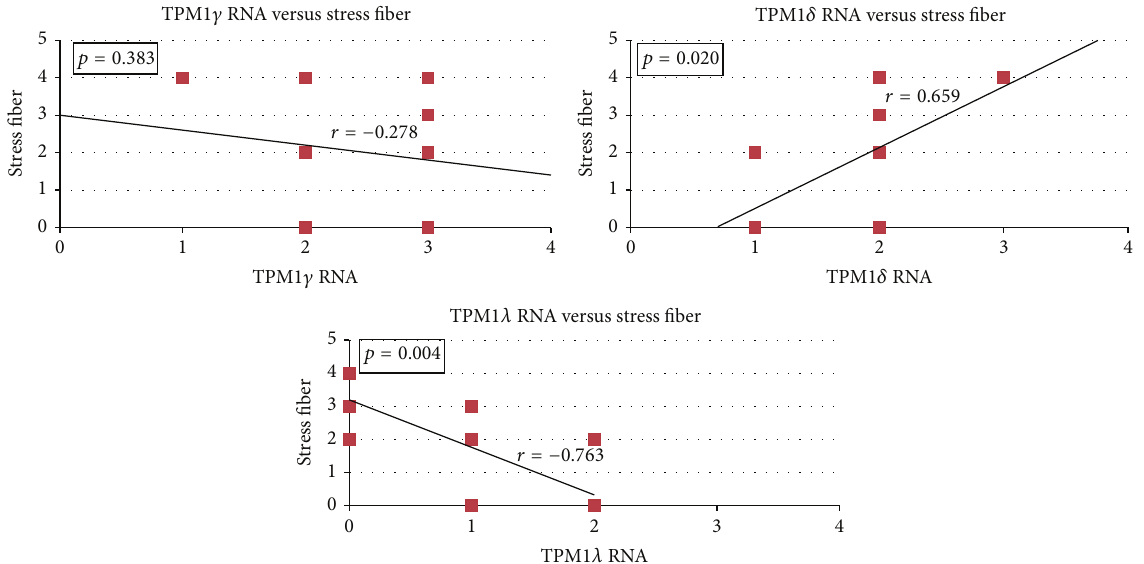
Figure 6: Regression analyses of stress fiber formation versus expression of TPM1 𝛾 , TPM1 𝛿 , or TPM1 𝜆 RNA among the breast epithelial cell lines. Each box represents one or more cell line(s). The correlation coefficients (𝑟) and 𝑝 values for each analysis are shown. As can be seen, TPM1 𝛾 expression did not have a high correlation with stress fiber formation, while TPM1 𝛿 and TPM1 𝜆 RNA expression had high, significant, positive, and inverse correlations with stress fiber